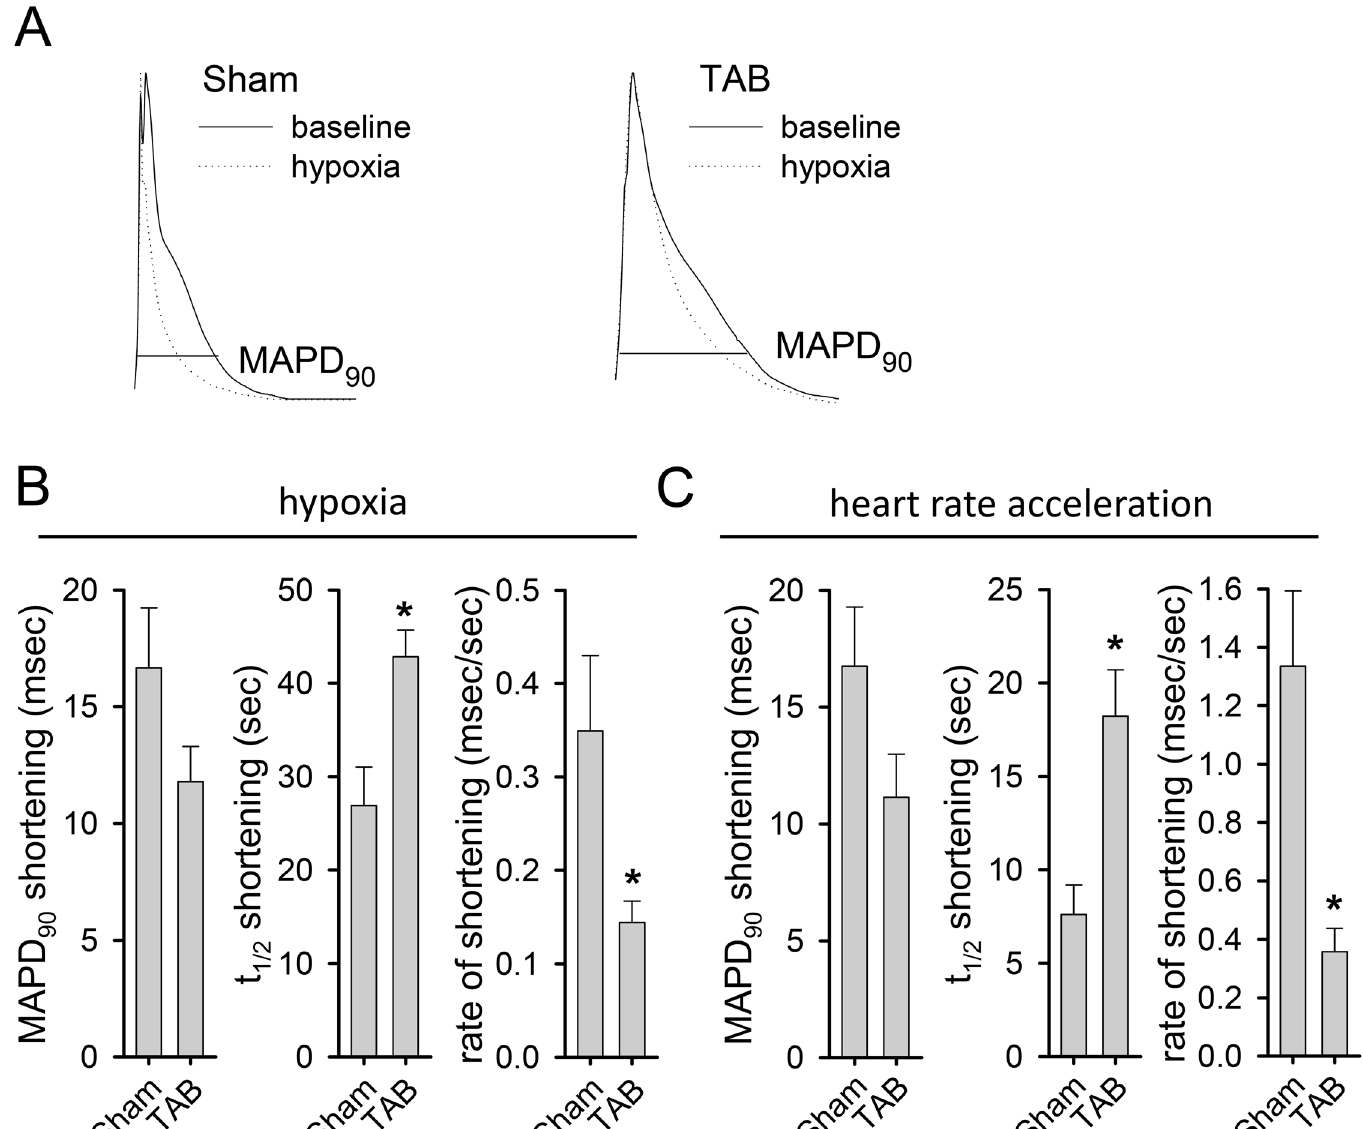
Fig 5. Monophasic action potential duration shortening is blunted in failing hearts. Monophasic action potentials were measured from a single left ventricular epicardial position in isolated hearts from TAB and sham mice before and during exposure to hypoxia or abrupt heart rate acceleration from 400 beats per minute (bpm) to 667 bpm (150 msec cycle length to 90 msec cycle length) driven by pacing. A) Representative normalized monophasic action potentials at baseline (solid lines) and in response to hypoxia (dotted lines) from hearts of sham (left panel) and TAB (right panel) mice. A horizontal line designates the point at which monophasic action potential duration at 90% repolarization (MAPD 90 ) was measured. B) Summary of MAPD 90 shortening (left), half-time (t 1/2 ) of MAPD 90 shortening (middle), and rate of MAPD 90 shortening (right) in hearts from sham and TAB mice in response to hypoxia ( * p < .05). C) Summary of MAPD 90 shortening (left), half-time (t 1/2 ) of MAPD 90 shortening (middle), and rate of MAPD 90 shortening (right) in hearts from sham and TAB mice in response to heart rate acceleration ( * p <